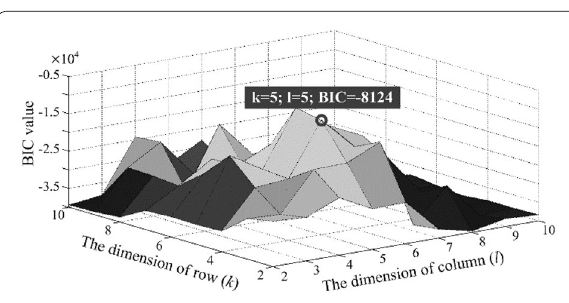
Figure 11 Varying load BIC